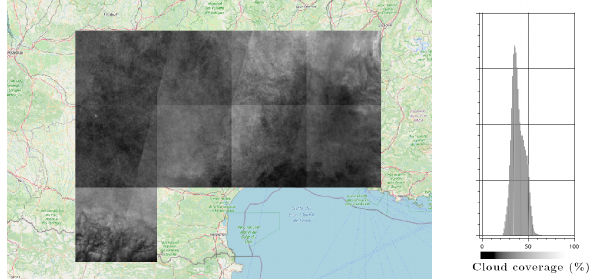
Figure 2. The cloud coverage over the area. Left: the percentage of cloud-free pixels in computed at each location. Right: histogram of the values. Mean cloud coverage: 39 . 13% , standard deviation: 6 . 80% . Map data © OpenStreetMap contributors, CC BY-SA size used per GPU, and training time is summarized in table 2 for each model.